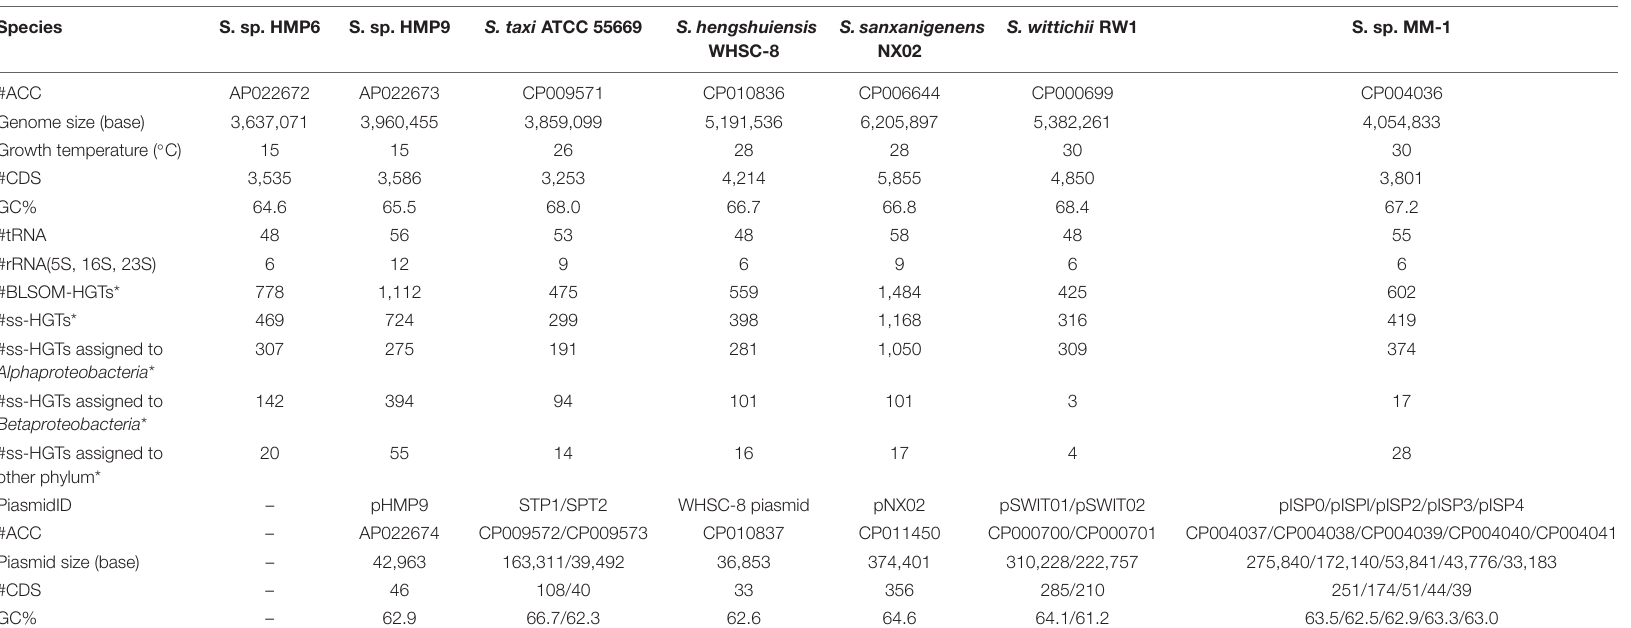
TABLE 1 | Genome information and number of HGT candidate genes.